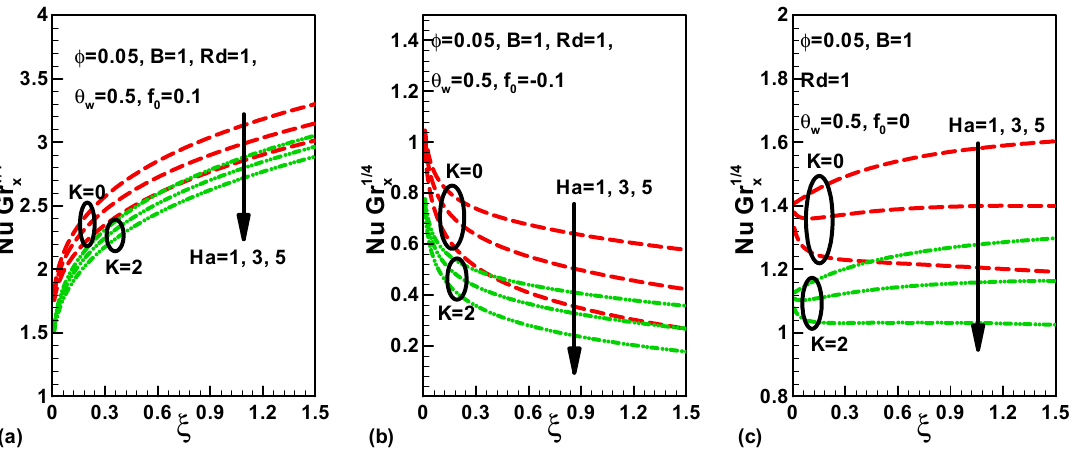
Figure 10. Effects of magnetic and micropolar parameters on Nusselt number along truncated cone for ( a ) suction, ( b ) injection, and ( c ) impermeable of kerosene-based magnetite nanofluid.